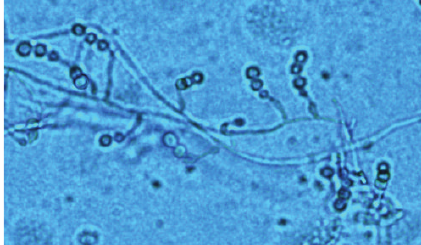
Figure 2: Microscopy. Lactophenol cotton blue stain. Note many overlapping conidiophores and conidia of Scopulariopsis sp. grown from patient’s BAL sample fluid (10x).